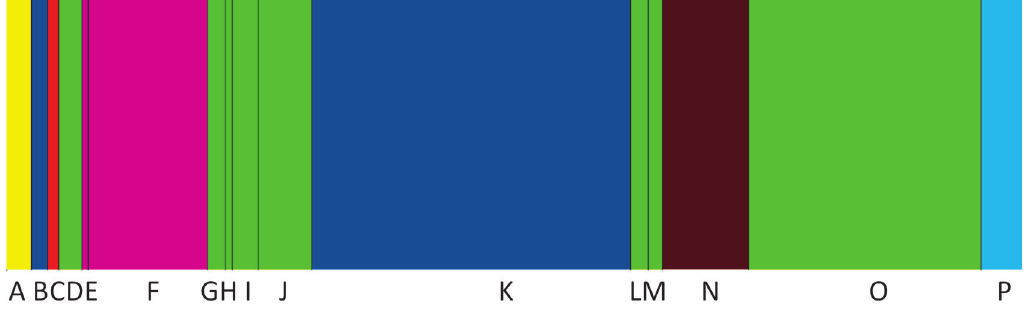
Figure 4. Clustering of Limousin herds by BAPS software. Clusters consisting more than one groups are: B, K (blue), D, G, H, I, J, L, M, O (green), E, F (cyclamen). Horizontal widths of the rectangles are proportional to the number of individuals genotyped within a herd. Group boundaries are vertical black lines.